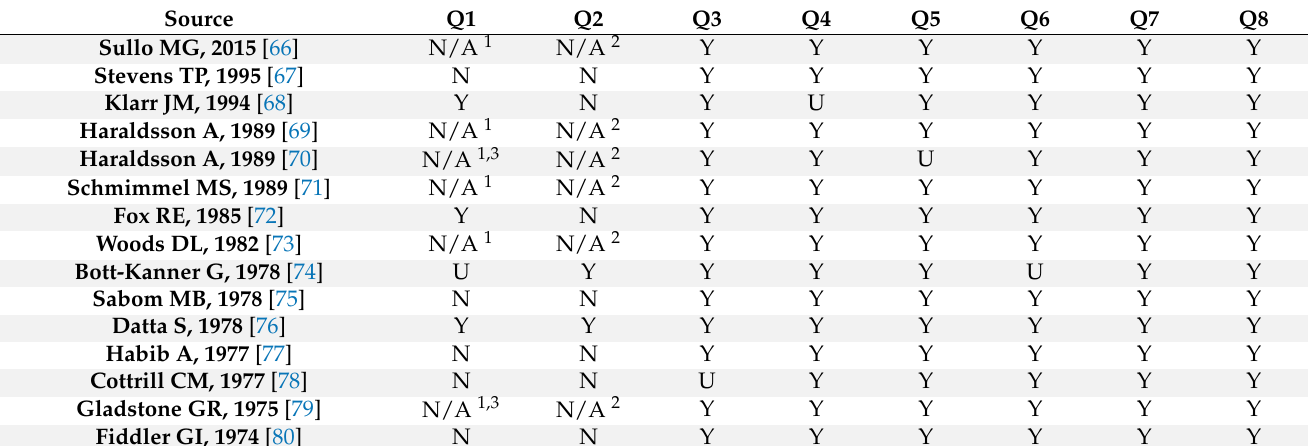
Table 7. Quality of 15 case